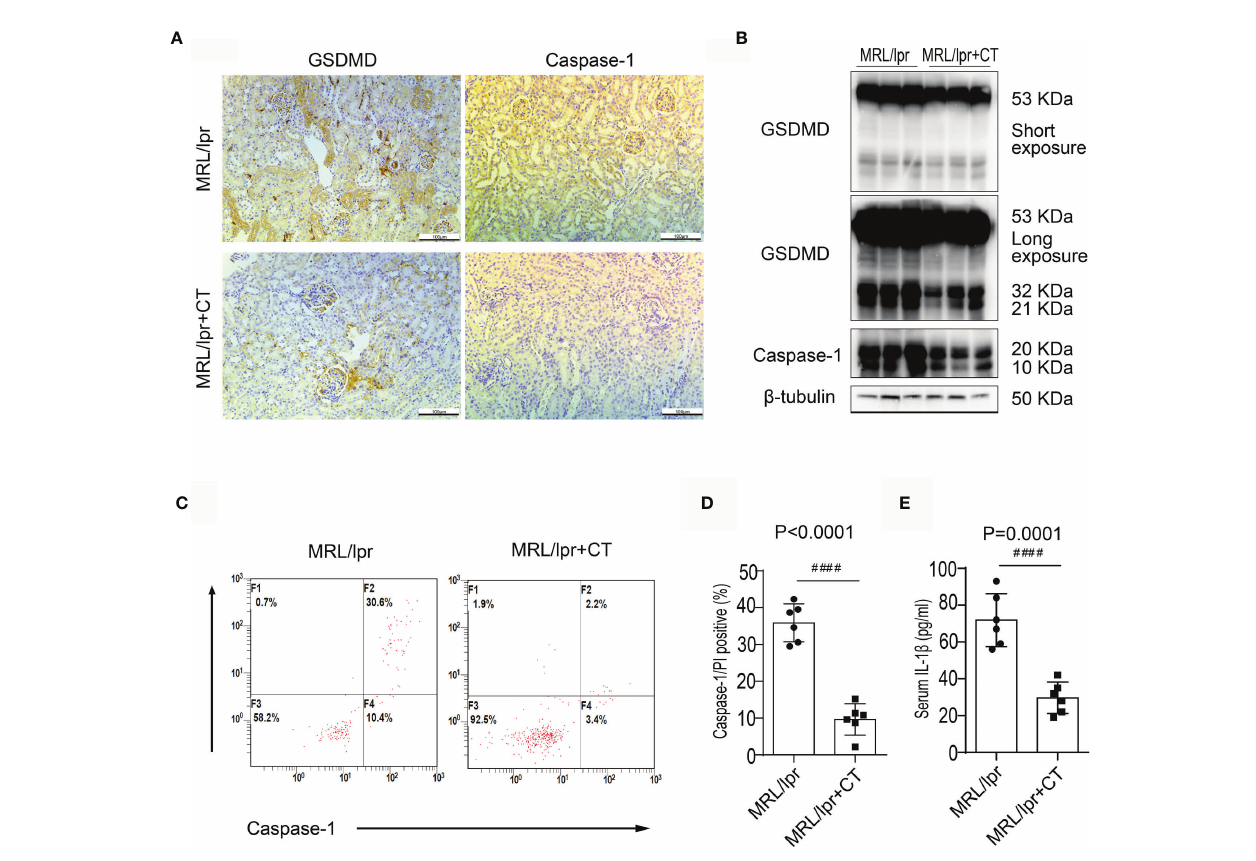
FIGURE 3 | Combination treatment attenuated caspase-1/GSDMD-mediated pyroptosis in MRL/lpr mice. (A) Immunochemical staining of GSDMD and caspase-1 in MRL/lpr mice kidney specimens. Compared to the vehicle control, caspase-1 and GSDMD expression was markedly inhibited in the combination treatment group. (B) Immunoblot analysis of full-length and cleaved GSDMD and caspase-1 in renal cortex specimens of MRL/lpr mice; comparison of results from the vehicle and combination treatment groups. (C) FACS of caspase-1/PI double positive cells in peripheral blood from MRL/lpr mice who were given or not given combination treatment. (D) Quanti fi cation of caspase-1/PI double positive cells in peripheral blood of MRL/lpr mice given or not given combination therapy. (E) Quanti fi cation of serum IL-1 b concentrations in MRL/lpr mice given or not given combination treatment. #### P < 0.0001. FACS, fl uorescence-activated cell sorting; CT, combination